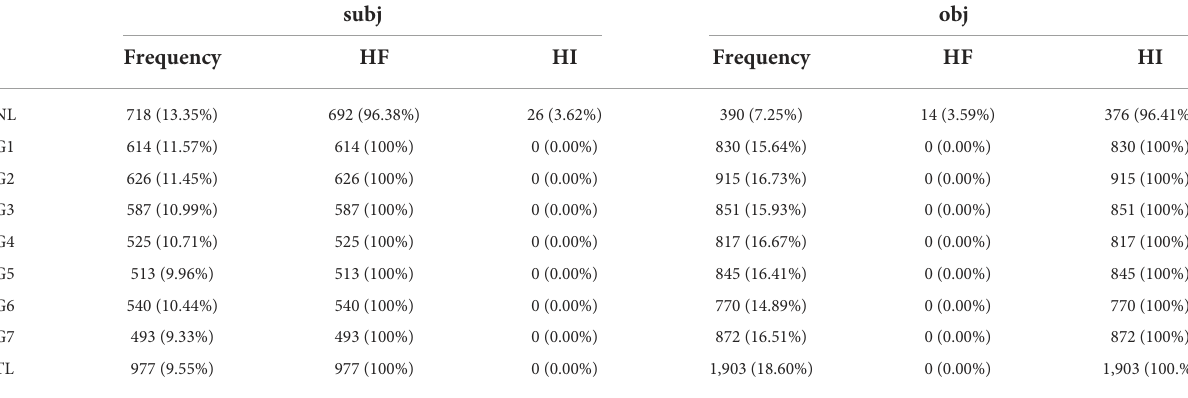
TABLE 3 In written modality, frequencies and dependency direction distributions of subjects and objects at each level and in contrastive treebanks.